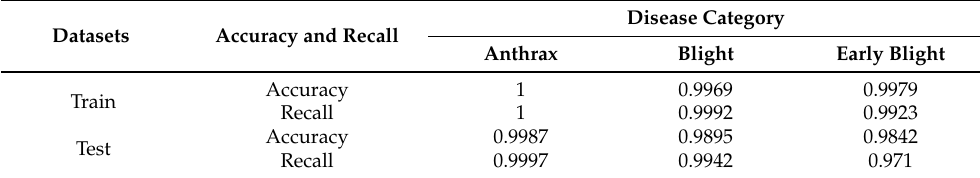
Figure 11. Confusion matrix of the three disease identification results using 1D-CNN. Table 6. Accuracy and recall of prediction results for different disease